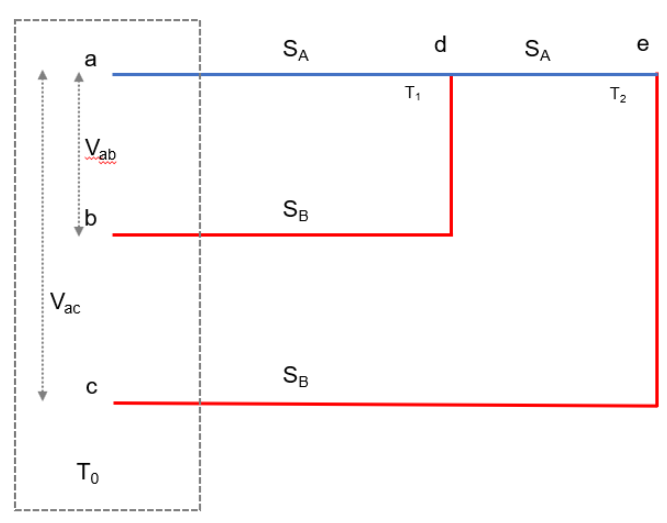
Figure 1. Schematic diagram of recursive unit for “ N + 1 ” array architecture. The red and blue lines indicate two di ff erent thermoelement types. Each red line may be a di ff erent material, however in this study only two distinct thermoelement materials were used. Here ‘ V ab ’ and ‘ V ac ’ are the resultant thermocouple (TC) voltages produced by a temperature gradient between the ‘cold junctions’ ( a , b , c ) which are maintained at ‘ T 0 ' , and the ‘hot junctions’ ( d , e ) with temperatures ‘ T 1 ' and ‘ T 2 ' respectively.